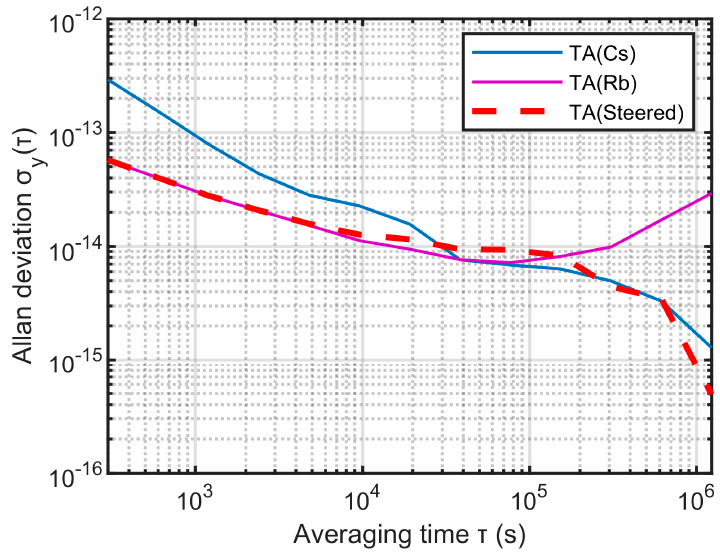
Figure 14. The frequency stability of TA(Cs), TA(Rb), TA(Steered). Using the traditional KPW time scale algorithm, 24 clocks are formed into a clock group to output the time scale TA(KPW), and the time scale output by the method proposed in this paper is TA(Steered). Their frequency stability comparison is shown in Figure 15: